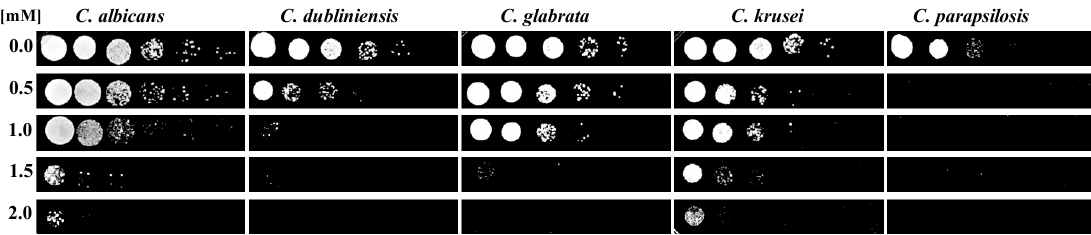
Figure 1. Susceptibility test of the five Candida species exposed to the Cd–Hg mixture ranging from 0 to 2.0 mM of total cation concentration. Cation ratio is fixed at 1:1.